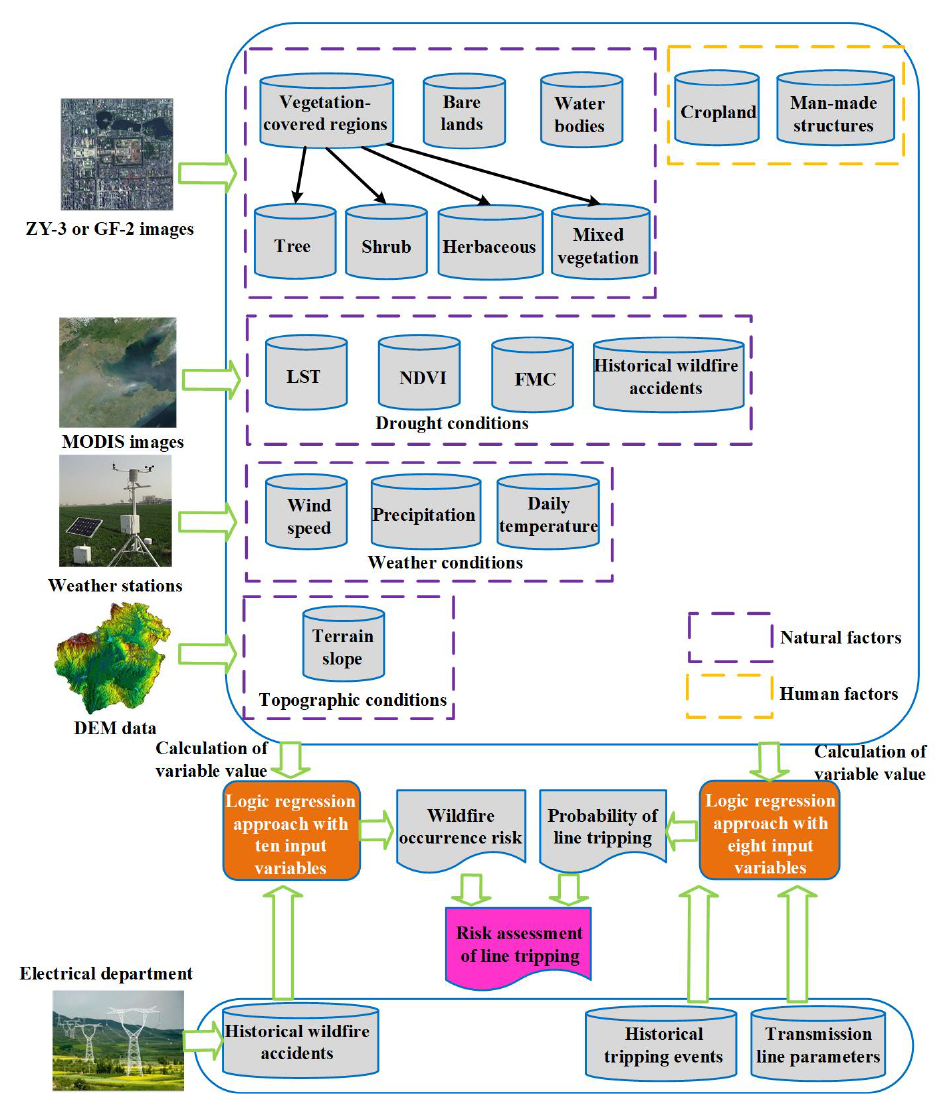
Figure 1. Block diagram of the model developed to assess the risk of line tripping caused by wildfire occurrence in high-voltage power line corridors. LST: land surface temperature; NDVI: normalized difference vegetation index; FMC: fuel moisture content; MODIS: Moderate Resolution Imaging Spectroradiometer; and DEM: digital elevation model.